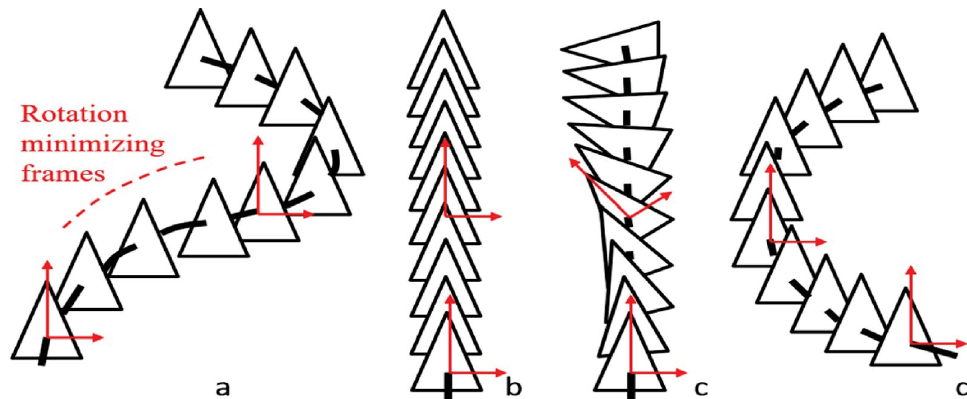
Fig. 7 Three examples showing the process of deforming the centerline and moving the CSs. (a) A centerline & CSs computed using the relative curvature condition. There is no intersection between cross-sectional curves inside the GC. For each CS, two directions are calculated using rotation minimizing frames. (b) Target centerline shape: straight, without twisting. (c) Target centerline shape: straight, with artificial twisting. (d) Target centerline shape: